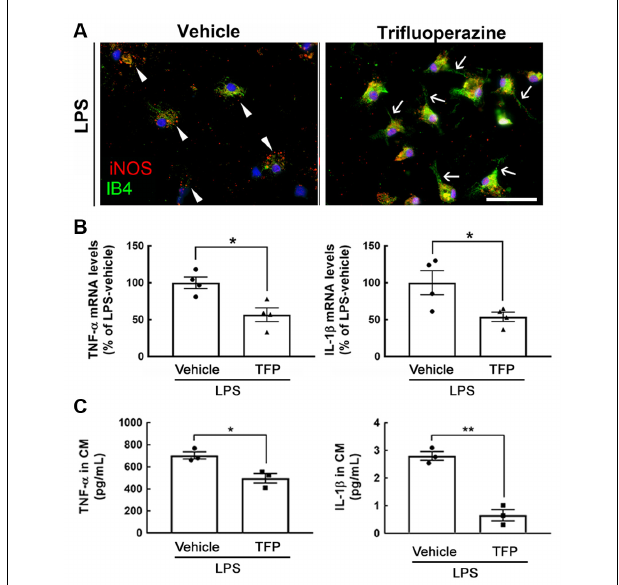
FIGURE 1 | Exposure to TFP suppresses the expression of proinflammatory mediators in glial cultures. (A) Mouse microglia were treated with 10 ng/ml of LPS and 1 µ M of TFP for 3 h, and then subjected to immunostaining for iNOS (red) and IB4 staining (green) as described in “Materials and Methods” section. Arrowheads indicate iNOS expression significantly in amoeboid microglia, and arrows show microglia with extending cell processes. Scale bar in (A) = 50 µ m. (B) Rat microglia were treated with vehicle or TFP in the presence of LPS for 6 h, and then their TNF- α and IL-1 β mRNA expression was measured by QPCR as described in “Materials and Methods” section. (C) Mouse hypothalamic mixed glial cells were treated with 1 µ M TFP in the presence of LPS (10 ng/ml) for 3 h. The levels of TNF- α and IL-1 β in the culture medium were measured using ELISA kits. The data are presented in ( B ; n = 4 experiments) and ( C ; n = 3 experiments) as the mean ± SEM. * p < 0.05, ** p < 0.01 vs.